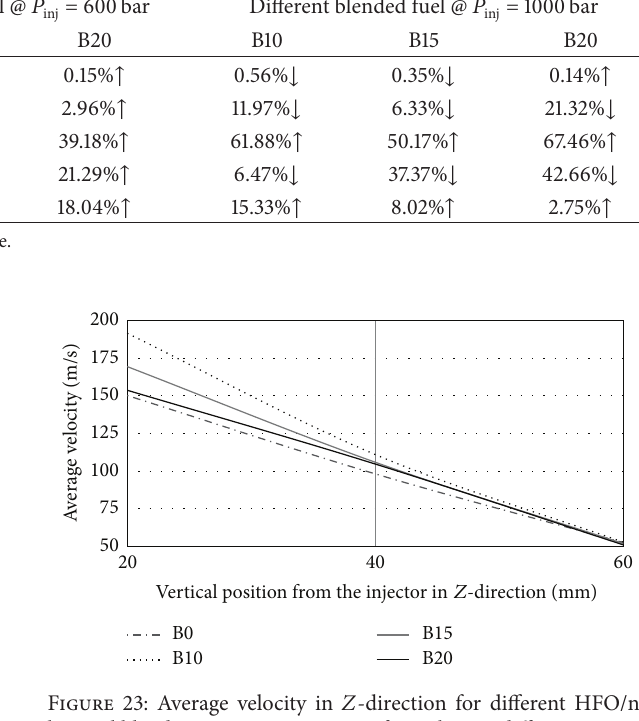
Figure 21: Average of particles diameter in parcels for different HFO/n-butanol blends at injection pressure of 1000bar on different vertical positions from the injector.